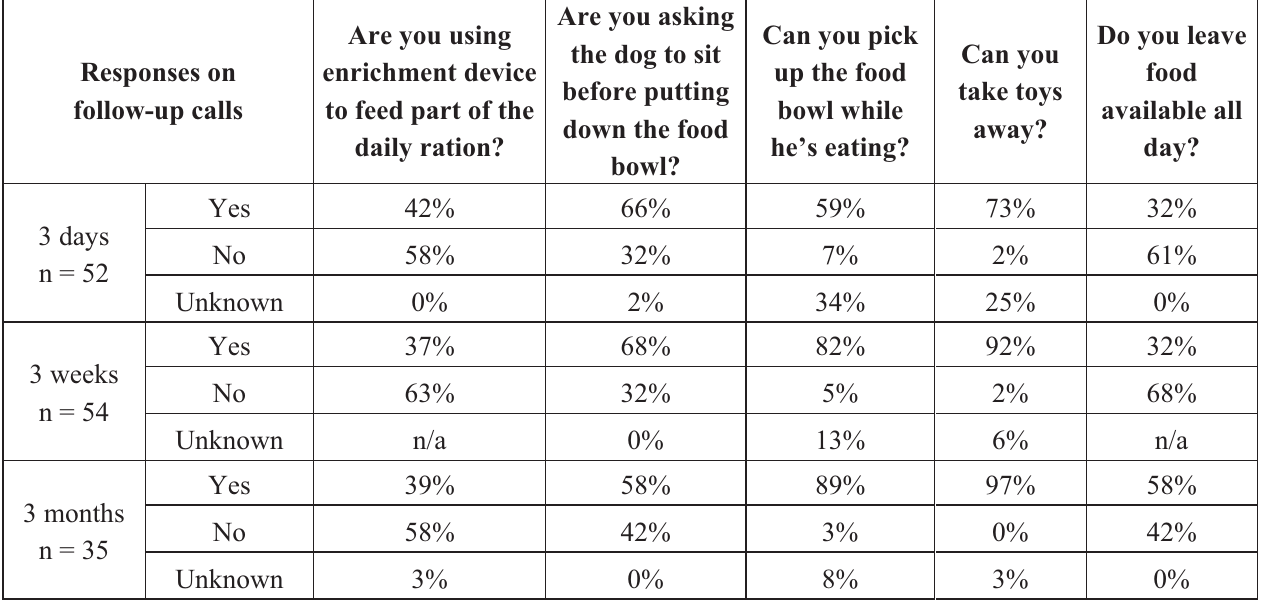
Table 4. Adopters’ responses at each follow-up to questions pertaining to interactions between them and their